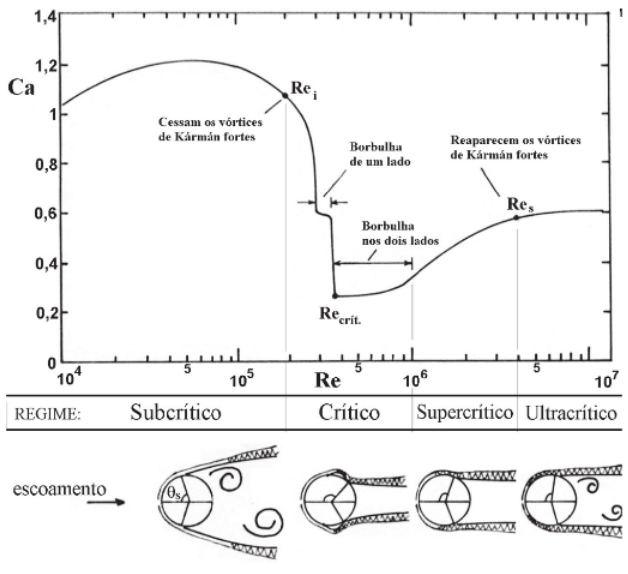
Flow characteristic regimes around cylinders. The Re values are illustrative only (Blessmann